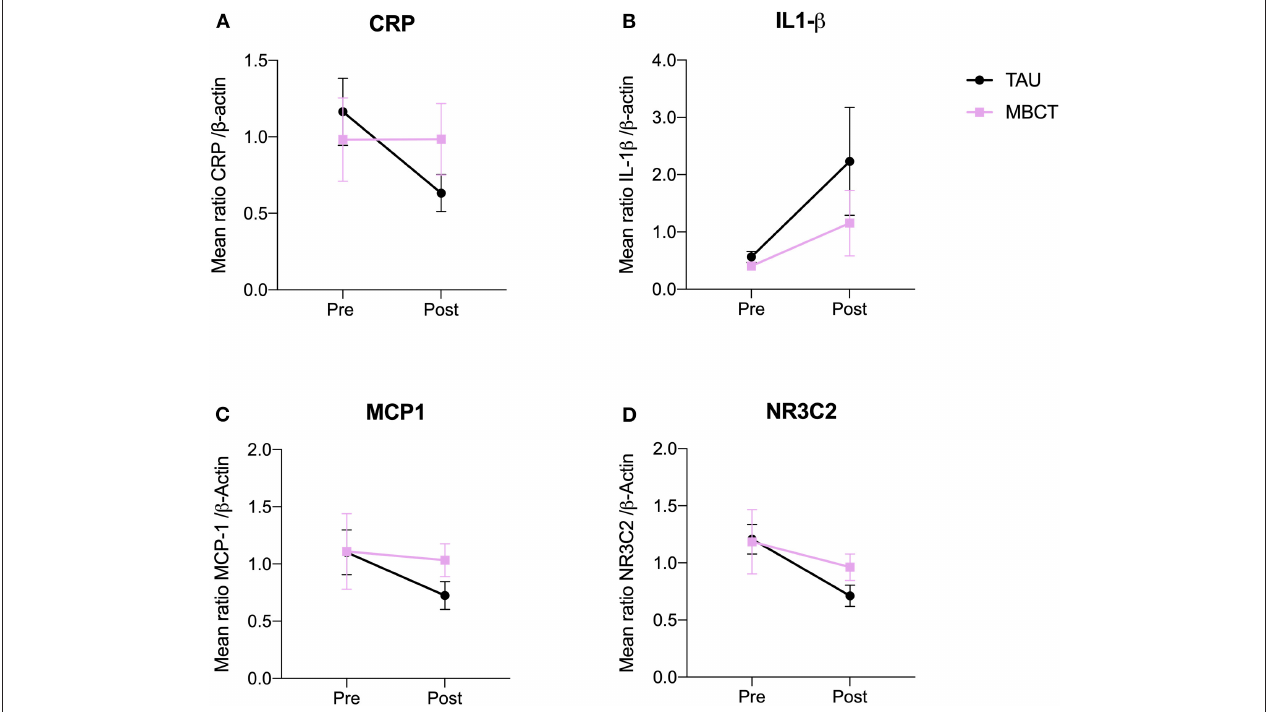
FIGURE 3 | Compared to TAU, MBCT is not accompanied by changes in the levels of CRP (A) , IL1- β (B) , MCP1 (C) , NR3C2 (D) . Error bars indicate standard deviation. MBCT, Mindfulness Based Cognitive Therapy treatment group; TAU, Treatment as usual group; CRP, C-reactive protein; IL1- β , Interleukin 1-Beta; MCP1, Monocyte chemoattractant protein-1; NR3C2, mineralocorticoid